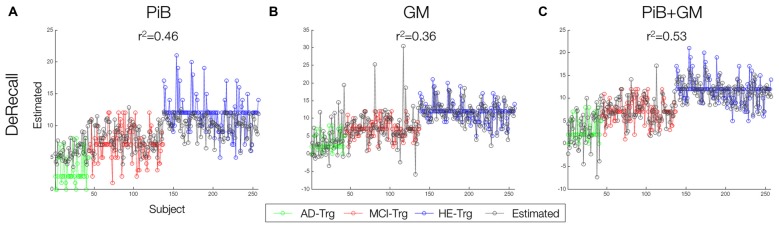
Predictions of three target values using single and multi-modal data. (A–C) Line prediction plot of delay memory recall scores. Individual GM an PiB modeled by KRR while multimodal GM-PiB modeled by sMKL. The closer a particular predicted data (gray) to the targeted data (in green, red and blue), the better the accuracy of sample data.